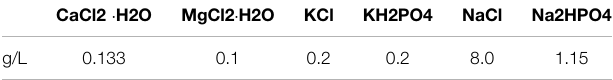
Figure 3A . EDS point analysis identi fi ed them as Zr-rich particles. Larger precipitates in the form of fl akes measuring a